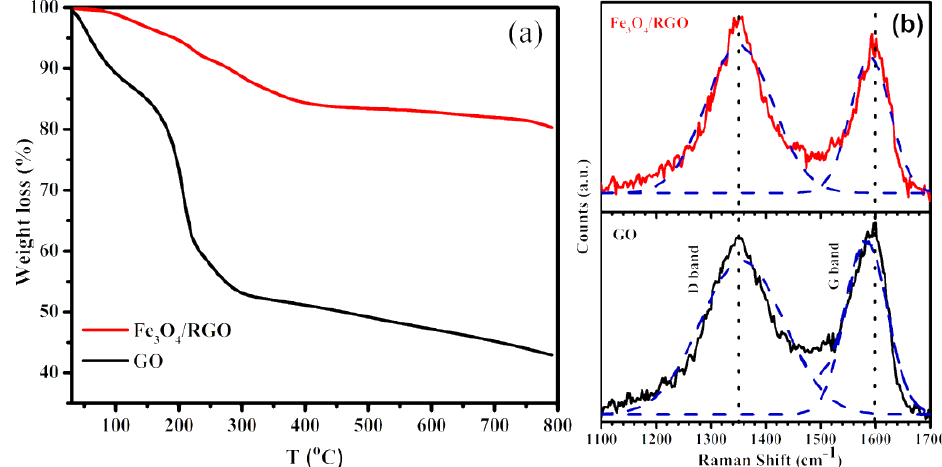
Figure 2. ( a ) TGA and ( b ) Raman analysis of GO and Fe 3 O 4